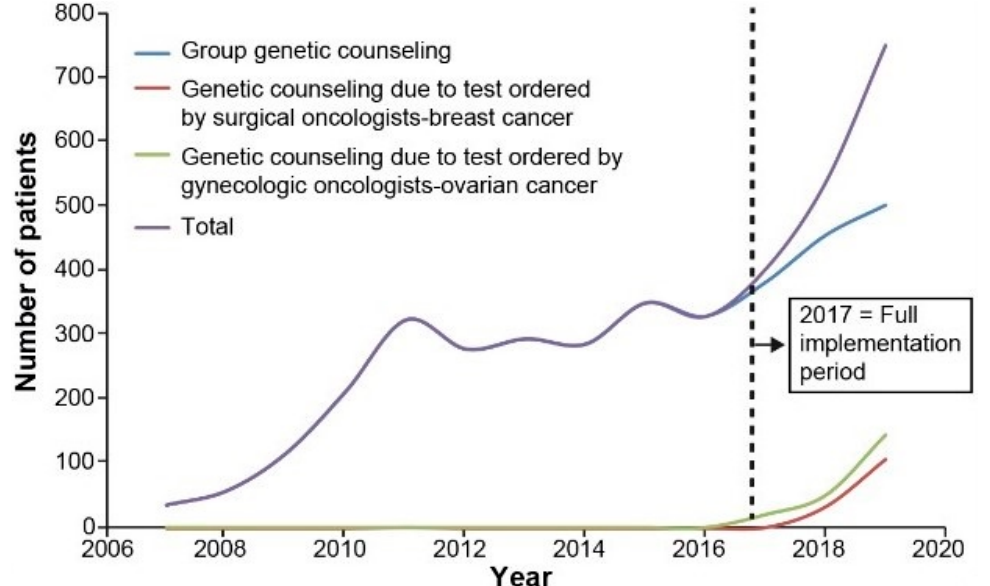
Figure 2. Number of Patients who Accessed Genetic Counseling for Hereditary Breast-Ovarian Cancer (HBOC) Over Time.